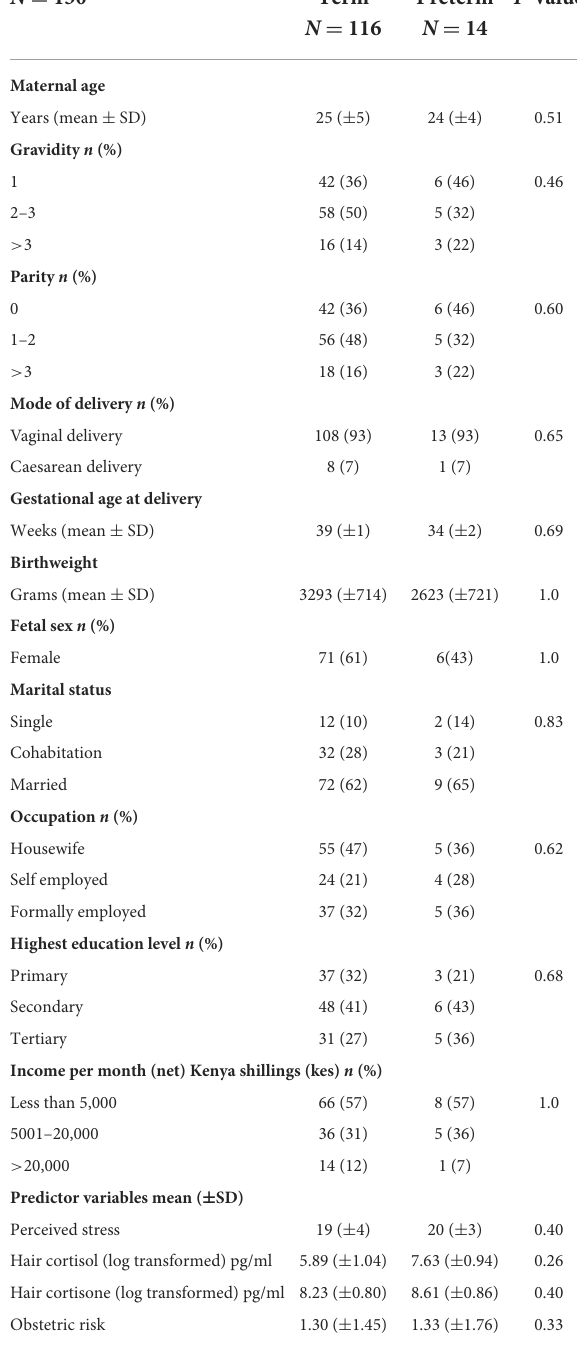
TABLE 1 Participants